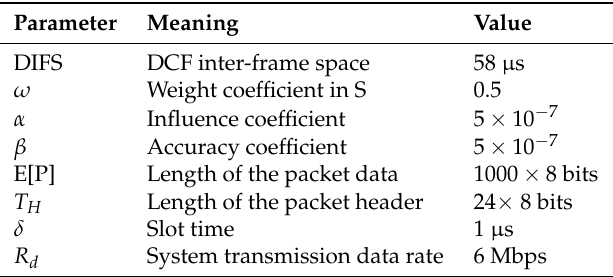
Table 1. Parameters in